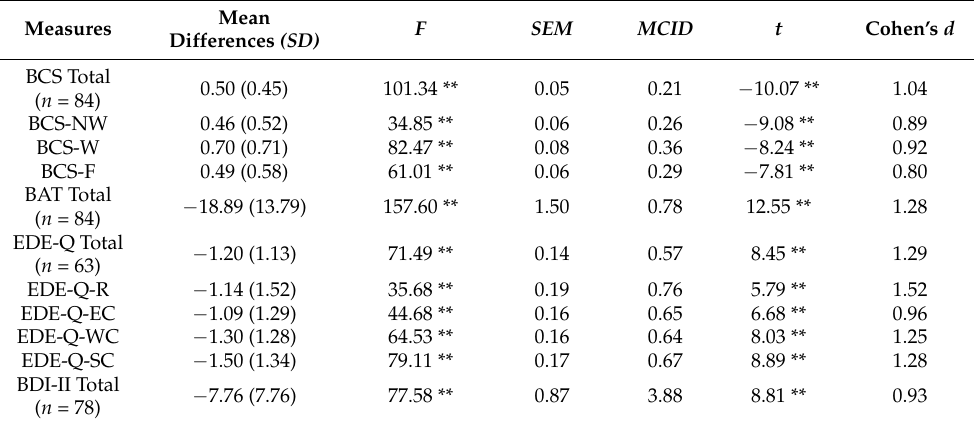
Table 4. Means ( M ) and standard deviations ( SD ) of the differences between pre- and post- intervention scores for all outcomes, results of repeated measure analyses ( F ) and minimal clinically important difference ( MCID ), test of the difference and effect sizes (Cohen’s d